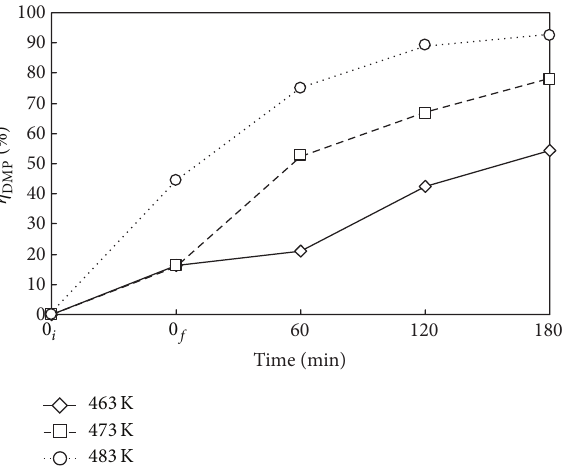
Figure 4: Time variation of 𝜂 DMP via WOP at various temperatures 𝑇 . ⬦ , ◻ , and I : 𝑇 = 463, 473, and 483 K. 𝐶 400 mL, 𝑃 𝑇 = 2.41MPa, and Nr = 500rpm. Working gas after time = 0 𝑓 is O 2 .